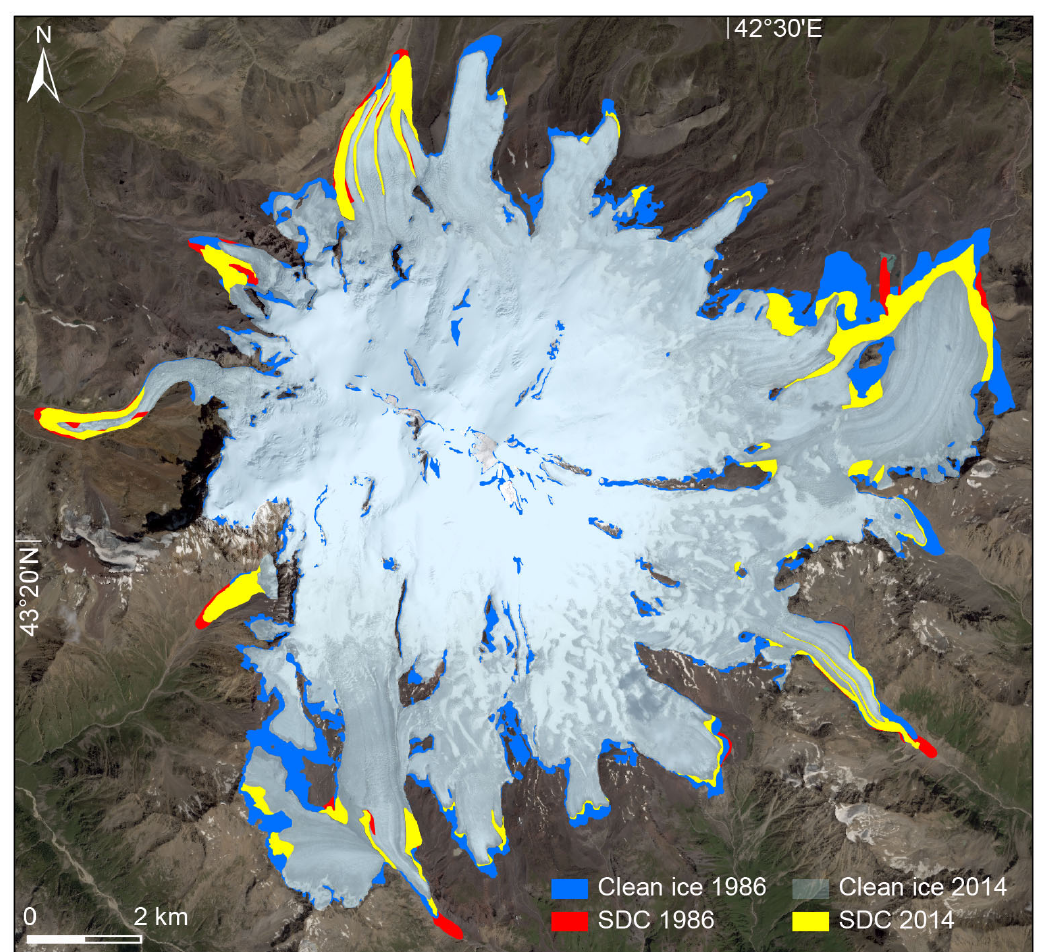
Figure 9. Supra-glacial debris cover (SDC) increase on the Elbrus Massif from 1986 to 2014. SPOT-7 image from 20 August 2016 is used as the background. Blue shows retreat of clean-ice parts. Clean ice in 1986 consists of the clean ice in 2014 (light blue, transparent) plus clean-ice area that retreated between 1986 and 2014 (dark